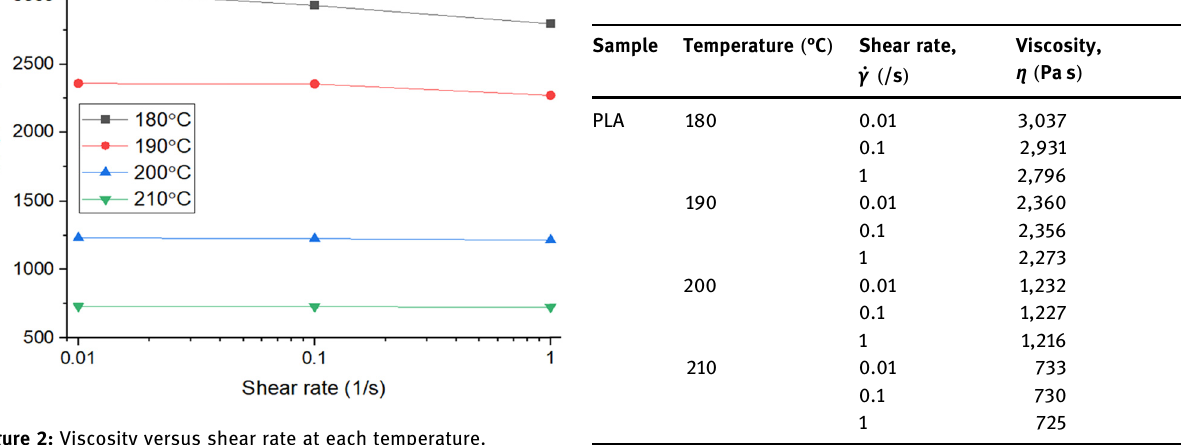
Table 1: Viscosity versus shear rate at each process